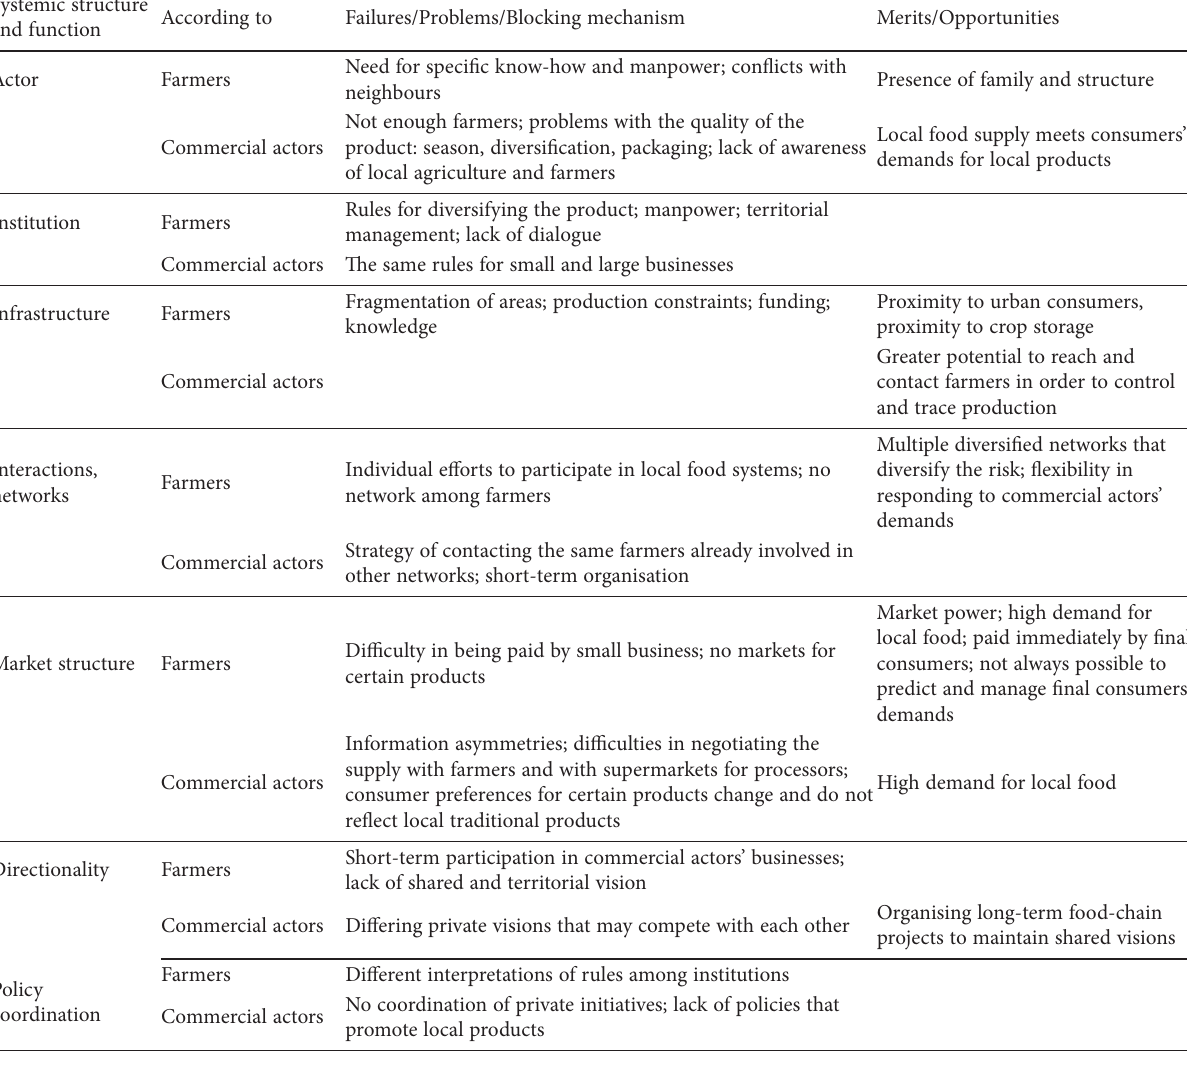
Table 3. The most important systemic failures and merits of systemic structures and functions according to farmers and commercial actors in the periurban region of Pisa